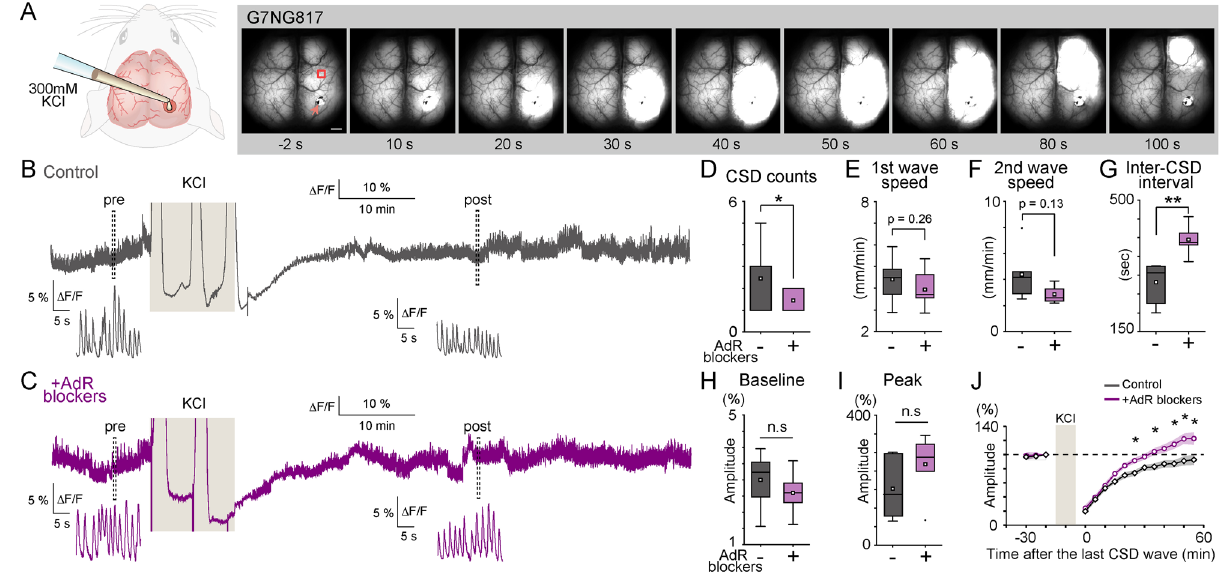
Figure 1. AdR antagonism suppresses CSD initiation and propagation. ( A ) Typical example of a CSD- associated Ca 2+ wave in an anesthetized G7NG817 mouse observed by transcranial cortex-wide macro imaging. KCl (300 mM) was topically applied to a small craniotomy above the visual cortex at time 0. The yellow arrowhead points to the KCl application site. Representative Ca 2+ dynamics shown in B and C were recorded in an ROI ~ 2 mm anterior to the KCl application site (red square). Scale bar 1 mm. ( B ) Example trace of Ca 2+ signal (G-CaMP7 ΔF/F) from the same animal shown in ( A ). Insets are magnified plots of the respective pre- and post-periods marked by dotted rectangles showing UP/DOWN state slow oscillations that occur during urethane anesthesia. ( C ) Similar Ca 2+ signal trace as ( A ). measured in a mouse pretreated with AdR pan-blockers. ( D ) Total count of CSD events. Untreated control: N = 9 mice, and AdR pretreated: N = 11 mice. ( E ) Propagation speed of the first CSD Ca 2+ wave. Untreated vs. treated, 4.4 ± 0.4 vs. 3.9 ± 0.2 mm/min. ( F ) Propagation speed of the second CSD Ca 2+ wave in mice multiple CSD waves were observed. Untreated control: N = 9 out of 11 mice, and AdR pretreated: N = 5 out of 11 mice. 4.4 ± 0.8 vs. 2.9 ± 0.3 mm/min. ( G ) Inter-CSD Ca 2+ wave interval. ( H ) Comparison of baseline neural activity amplitude. ΔF/F: 3.0 ± 0.4% vs. 2.6 ± 0.3%, n.s. ( I ) Comparison of the peak CSD amplitude. ΔF/F: 202.4 ± 32.8% vs. 268.3 ± 33.9%, n.s. ( J ) Effect of preemptive AdR blocker administration on the recovery of spontaneous neural activity. Spontaneous activity amplitude recovers in 30–40 min after KCl removal in mice pretreated with AdR blockers (N = 8 mice), whereas recovery in untreated control mice takes 60 min. Relative amplitude of spontaneous cortical Ca 2+ fluctuations before and after the last CSD wave passage (N = 8, normalized to the response 10 min before KCl). *p < 0.05, **p < 0.01, ***p < 0.001, error bars are